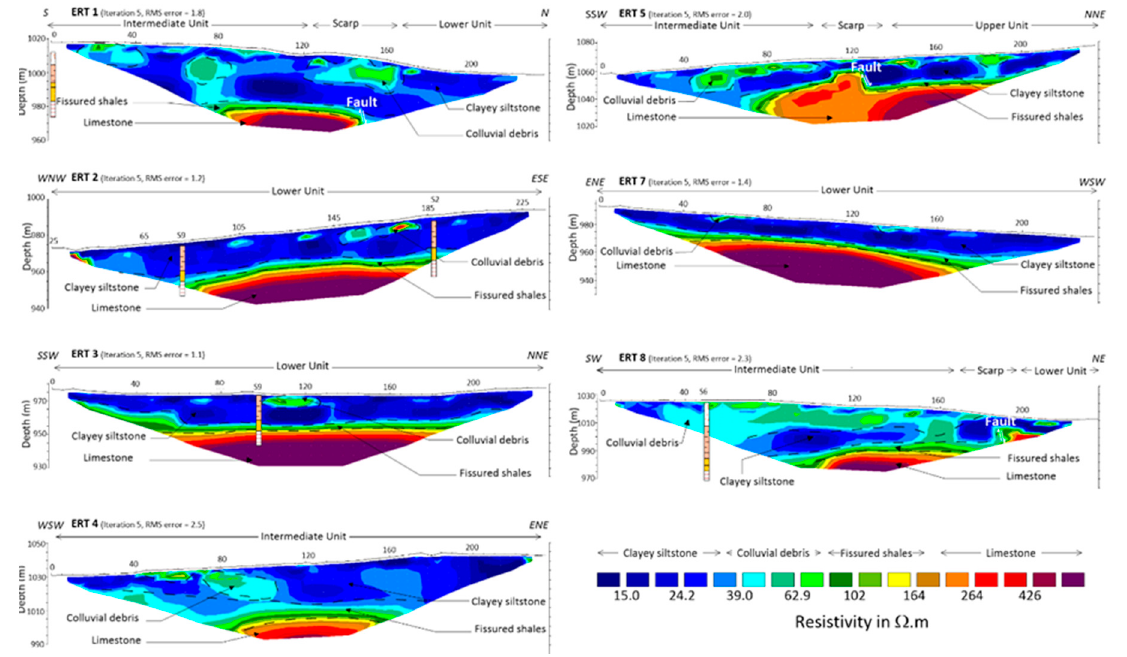
Figure 4. ERT inverted model resistivity cross-sections and their interpretation based on the strati- graphic boundaries from borehole lithological logs and electrical resistivity threshold values.